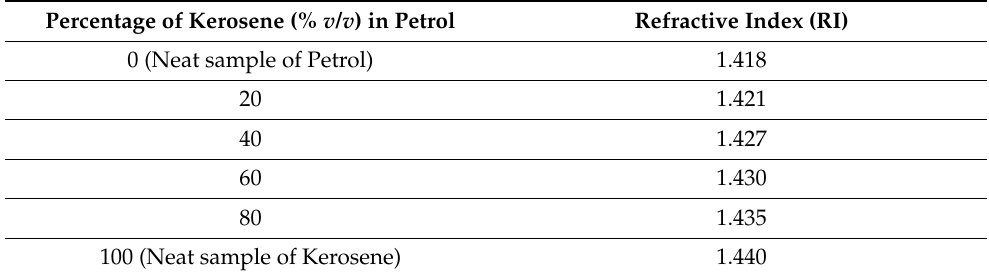
Table 1. The RI of adulterated petrol with different concentrations of kerosene [42]. Percentage of Kerosene (% v / v ) in Petrol Refractive Index (RI) 0 (Neat sample of